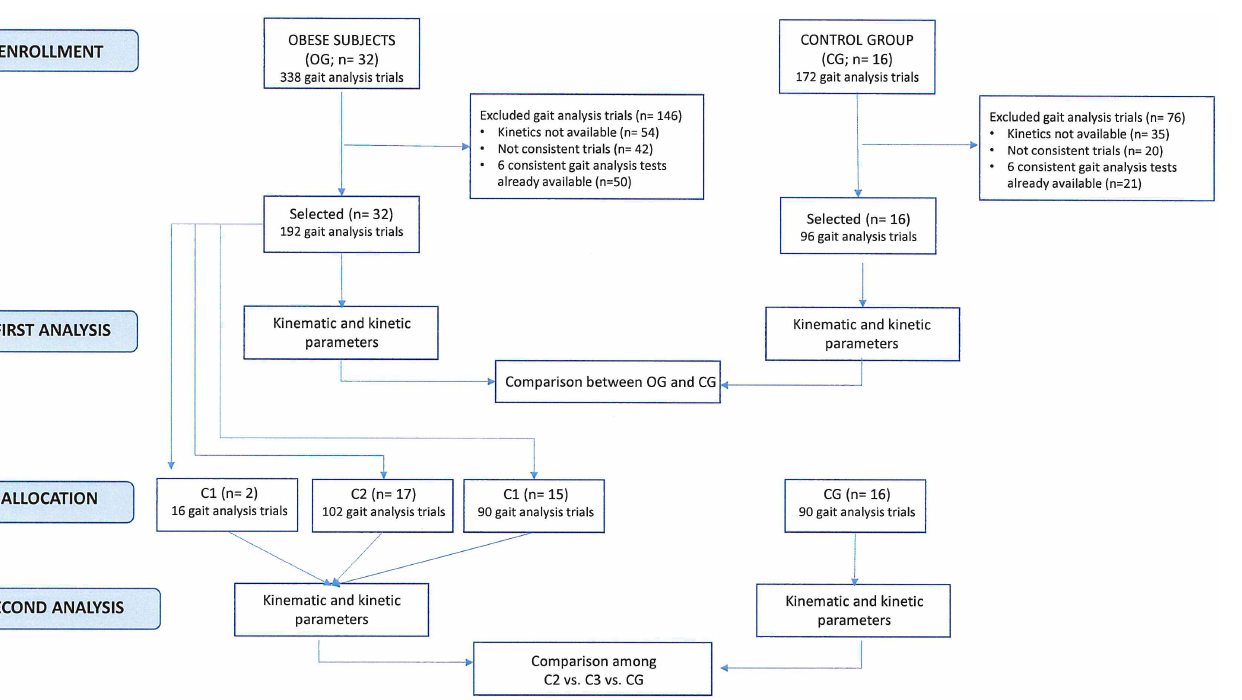
Figure 1. Flowchart of the experimental